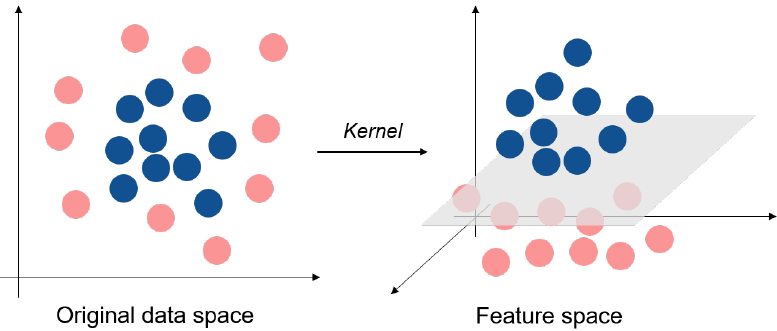
Figure 8. The principle of kernel-based methods. Using a kernel, the linearly inseparable input data are transformed to another feature space in which they become linearly